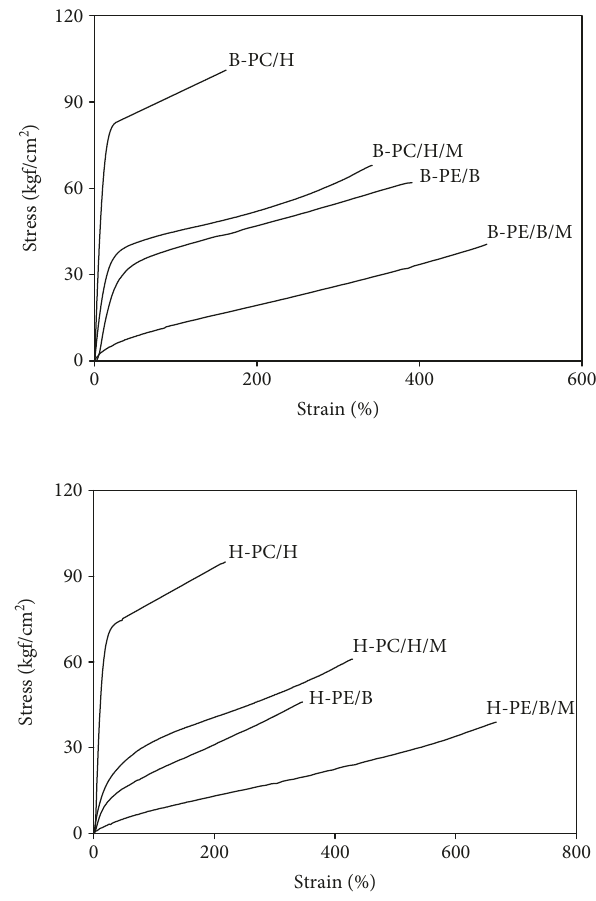
Figure 6: Stress-strain curves of polyurethane fi lms.